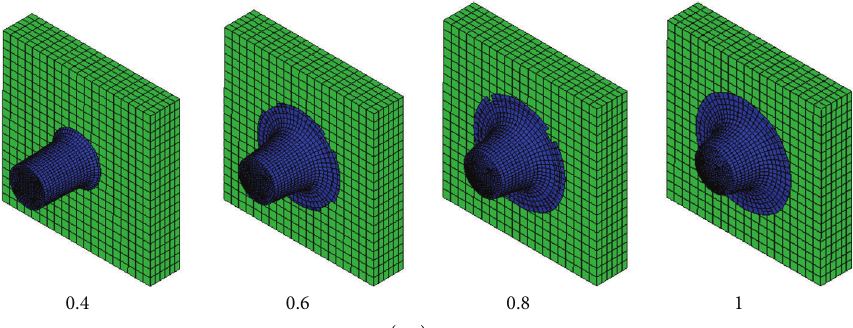
Figure 3: Deformation of bird on impacting rigid plate.